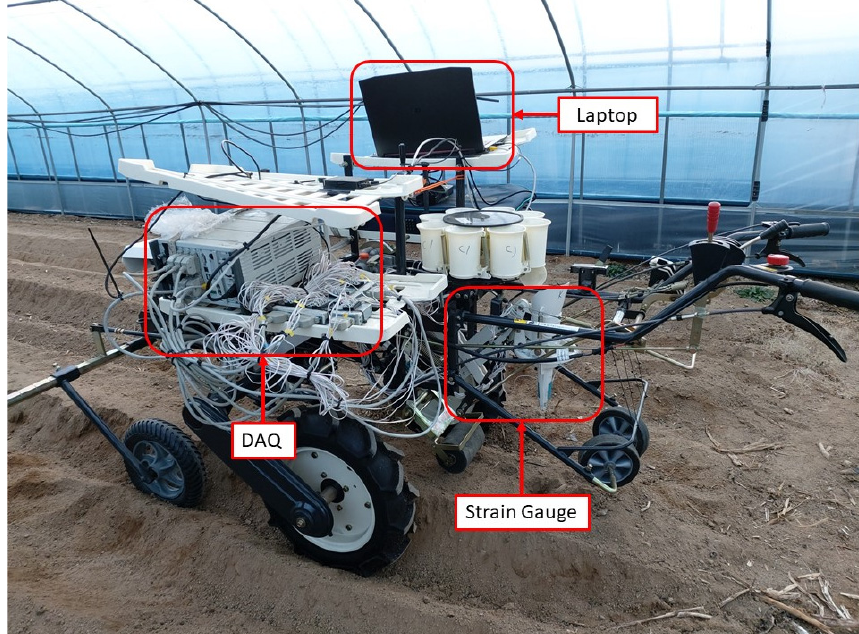
Figure 6. The load measurement system on the 4-bar link type semi-automatic vegetable trans- planter.